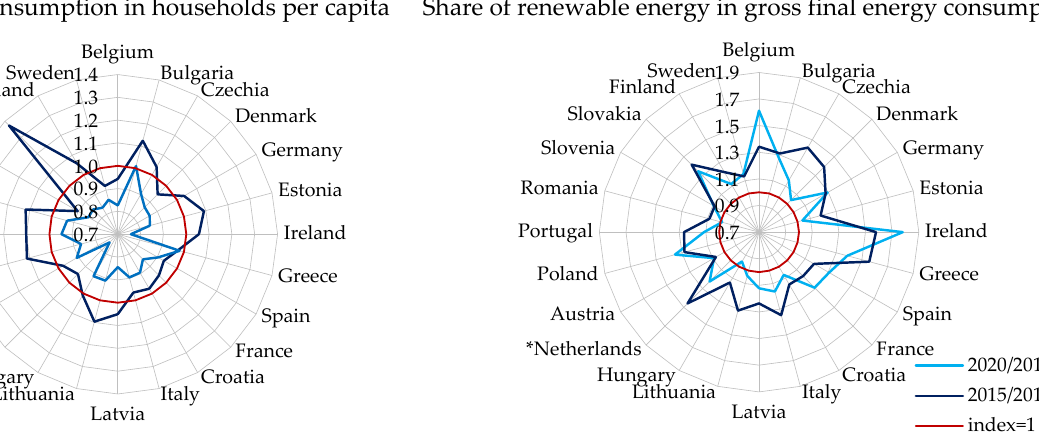
Figure 4 . Indices of energy sustainability indicators. *: index value 2020/2015 doubled.